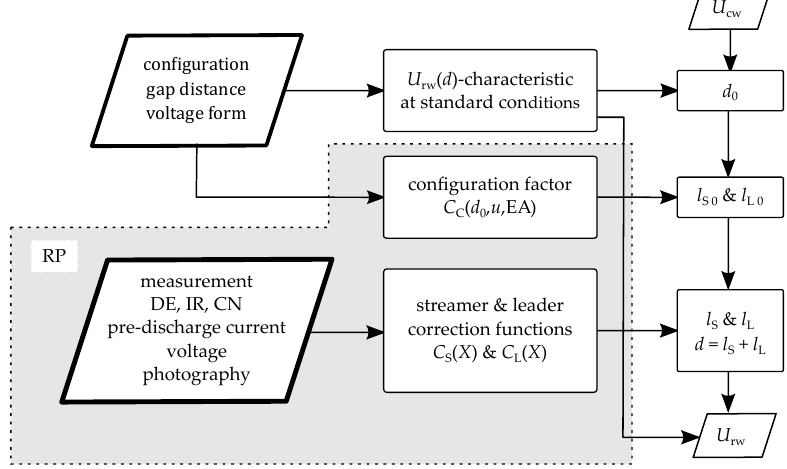
Figure 9. Outline of the proposed research project (RP) and flowchart of the hypothetical atmospheric correction method in reference to the withstand voltage correction of insulation